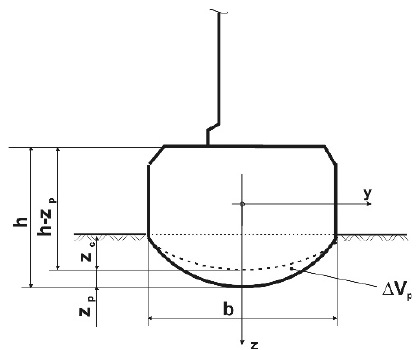
Figure 2. Tire cross section in the contact area (initial model).